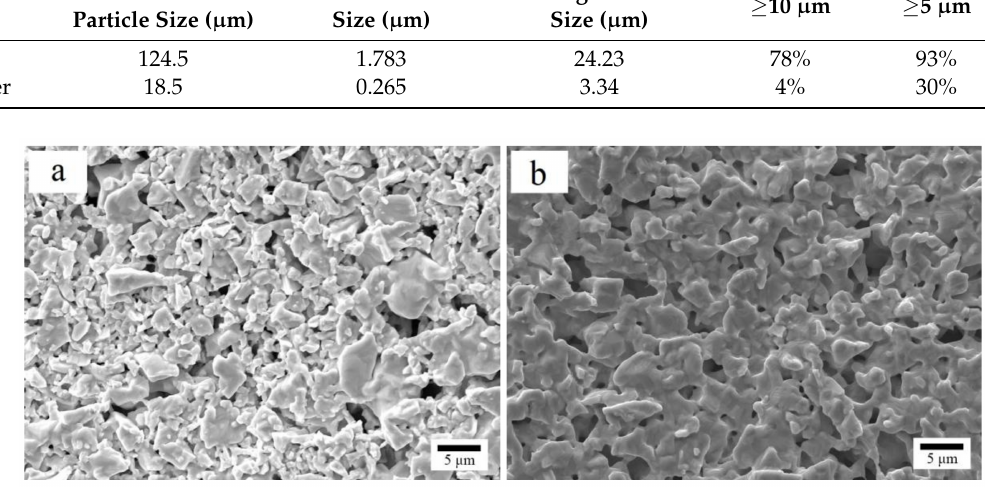
Figure 7. 850 ◦ C × 60 min substrate morphology (2000 × ) ( a ) and 900 ◦ C × 60 min Zr 98 Cu 2 film morphology ( b ).